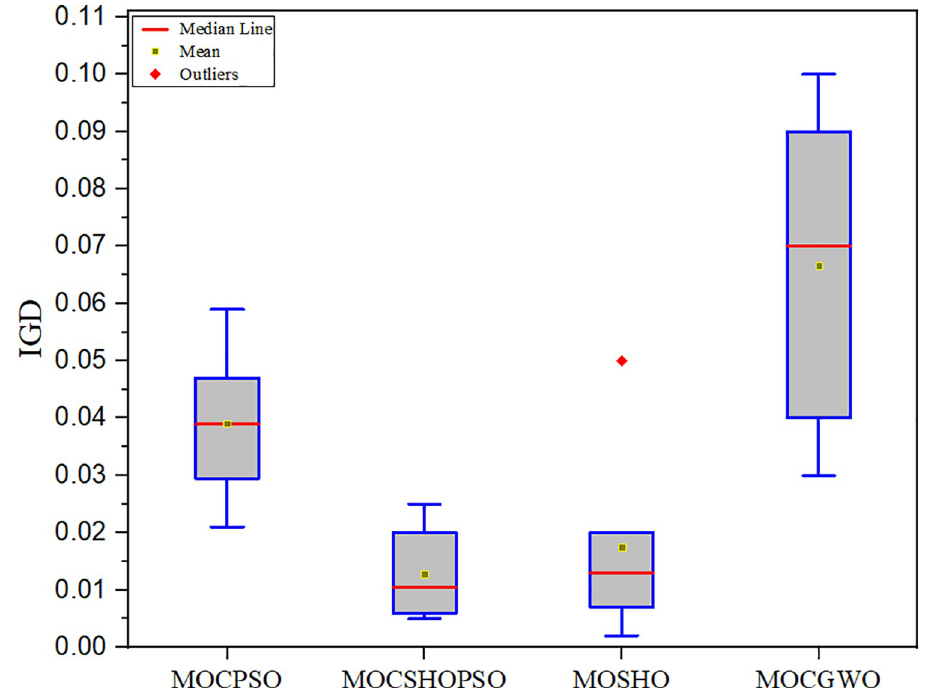
Fig 5. Box plot driven from the IGD comparison.